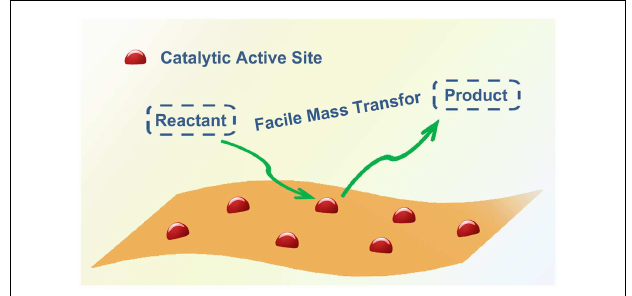
FIGURE 1 | Facile mass transfer of graphene supported heterogeneous catalysts